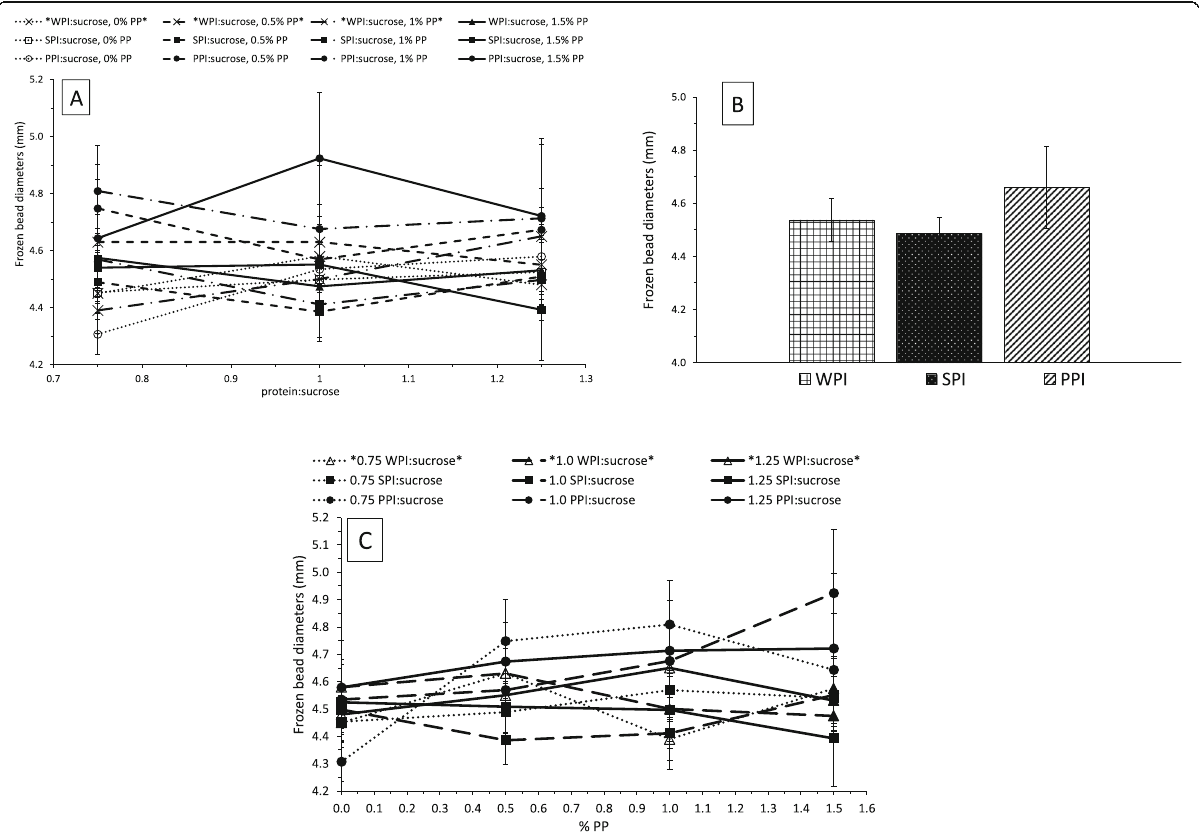
Fig. 11 Effect of protein:sucrose ratio ( A ), protein isolate type ( B ), and PP content (%) ( C ) on the on the diameters (mm) of frozen drops formed from dispersions; (averaged data plotted, n = 9). Legend entries marked * contain data points reported in previous work (Hansen et al., 2021a; averaged data plotted, n = 3). Lines are for guiding purposes only [ A, B